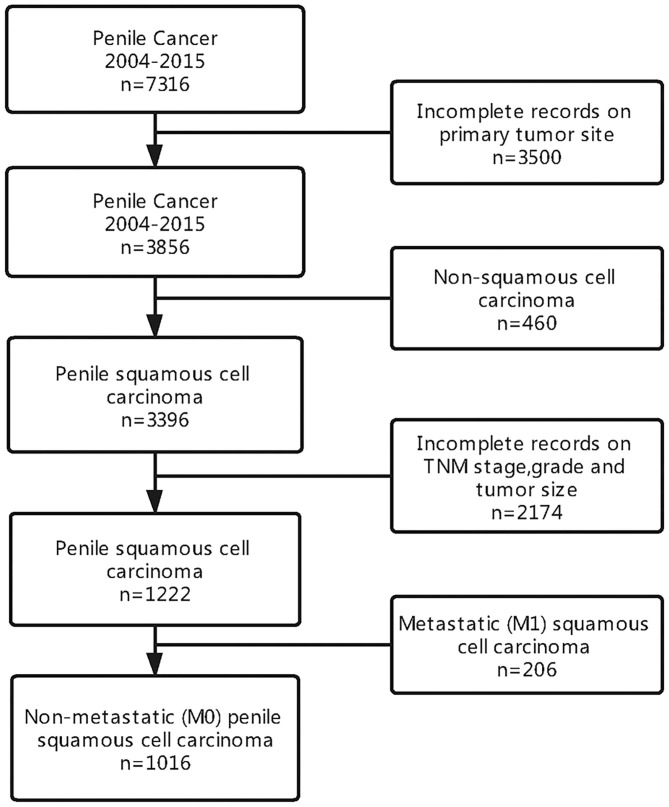
The flow diagram of patient selection.